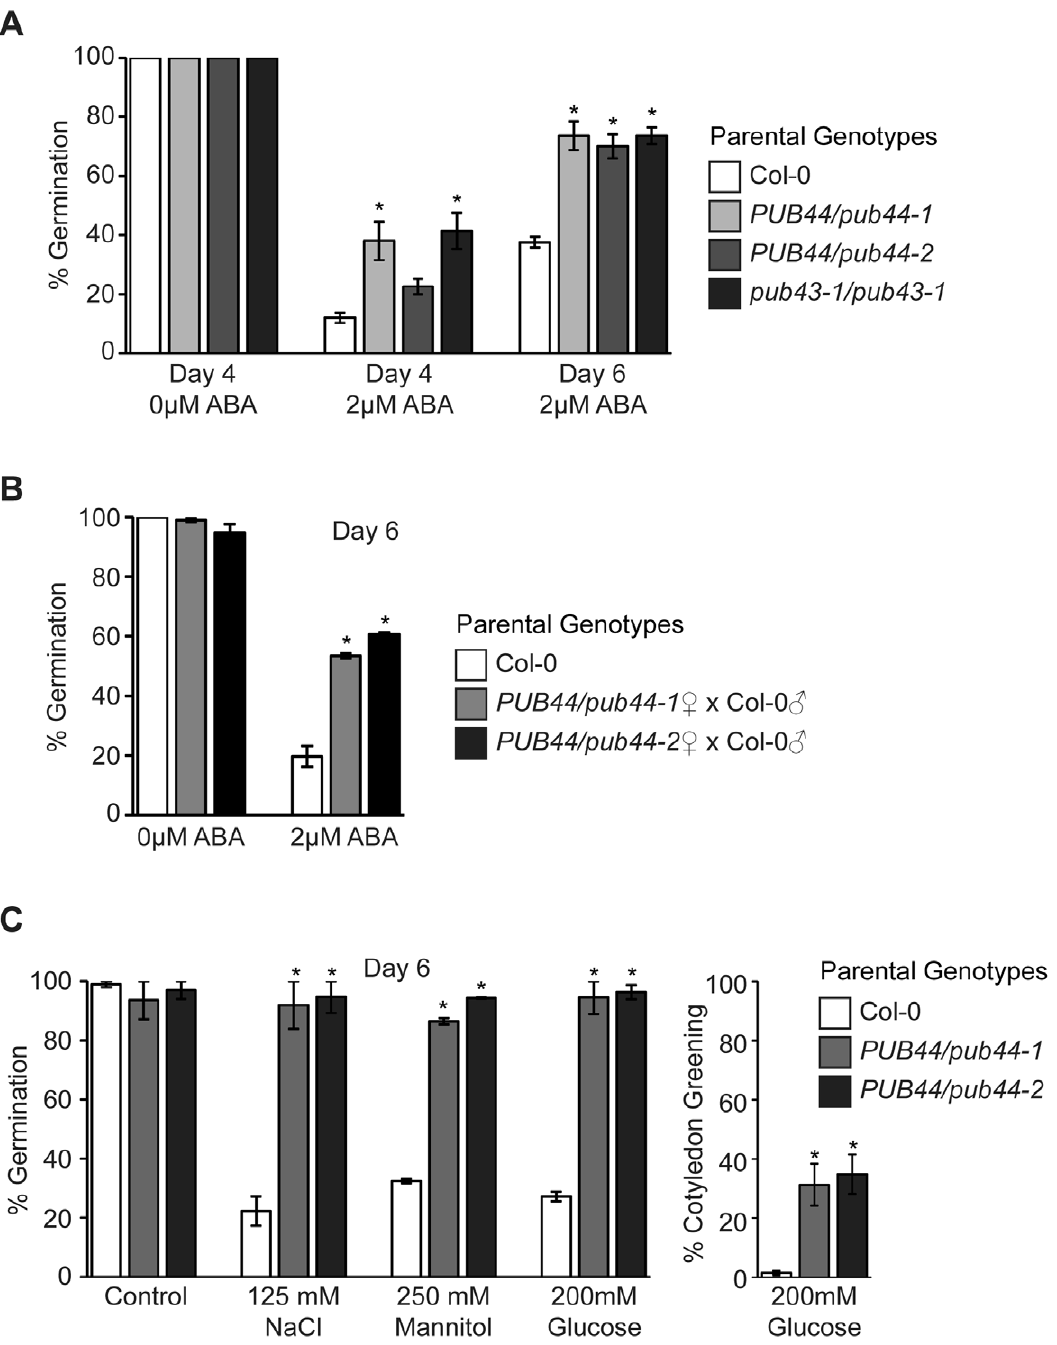
Figure 4. Responses of the pub44 and pub43 T–DNA lines to various stresses treatments during germination. ( A ) Seed germination rates at Days 4 and 6 for seeds planted on 0 or 2 m M ABA. Germination was scored when the radicle was fully emerged. Seeds from heterozygous PUB44/pub44 and homozygous pub43/pub43 plants showed decreased sensitivity to ABA during germination in comparison to Col-0 seeds. ( B ) Seed germination rates and segregation of the pub44 allele in seeds with decreased sensitivity to ABA. Seeds from a PUB44/pub44 R x Col-0 = cross were subjected to germination assays in the presence of 2 m M ABA and germinated seedlings were genotyped for the presence of the pub44 allele. A 1:1 ratio of wild-type and PUB44/pub44 seedlings were observed in the germinated seedlings displaying decreased sensitivity to ABA [n= 100 47:53; x 2 = 0.36, P , 0.05]. ( C ) Seed germination rates for seeds from PUB44/pub44 plants at Days 6 plated on 125 mM NaCl, 250 mM mannitol, or 200 mM glucose. Cotyledon greening was also assessed for the seedlings plated on 200 mM glucose. Decreased sensitivity was observed for seeds from PUB44/pub44 heterozygous plants under all conditions. Asterisks represent statistically significant differences (P . 0.05) when compared to appropriate Col-0 controls. n . 50 with 3 replicates per assay.